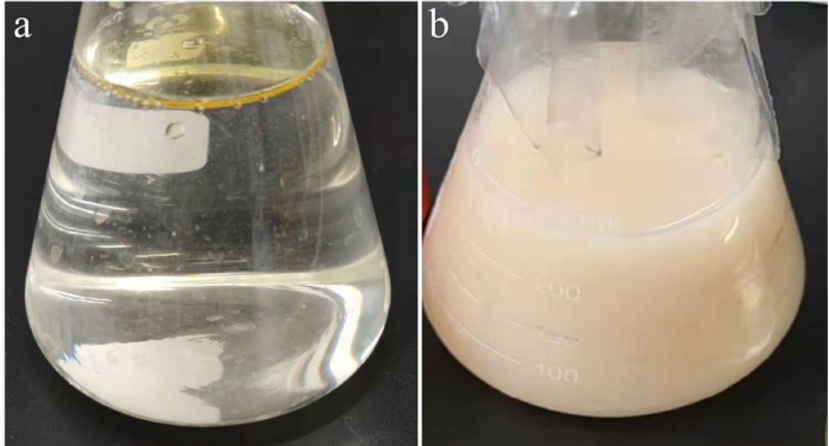
Figure 5. Photograph of WCO fermentation ( a ) initial (0 h) ( b ) After fermentation (120